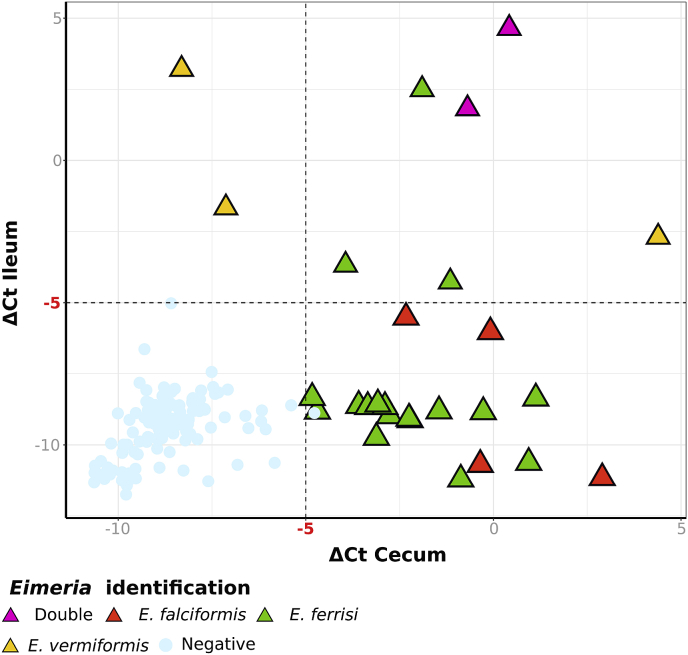
qPCR detection of intracellular stages of Eimeria in cecum and ileum from Mus musculus. -Delta Ct value (CtEimeria - CtMouse) from each tissue for 164 mice are plotted on the graph. The dotted line indicate the threshold of −5, values above the line are considered positive for the corresponding tissue. Circles represent negative samples, triangles indicate samples with Eimeria species identification and colors correspond to the Eimeria species identified in those samples. (For interpretation of the references to color in this figure legend, the reader is referred to the Web version of this article.)